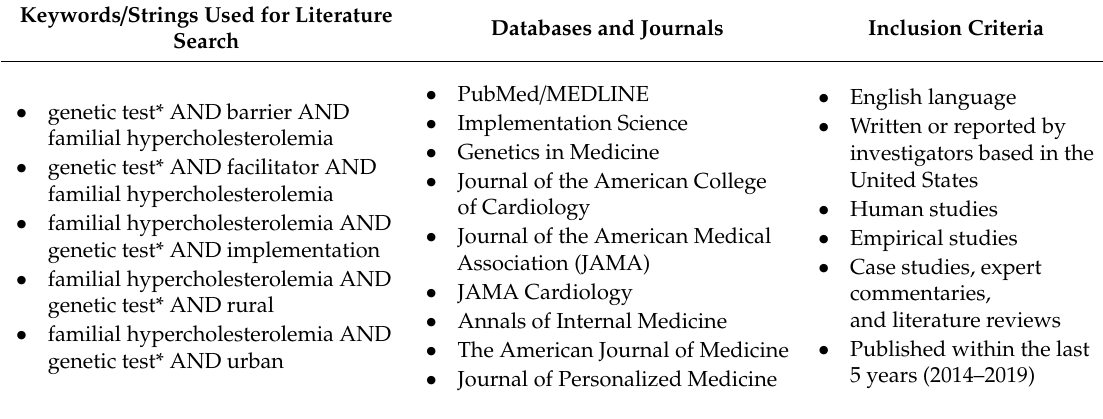
Table 1. Search Strategy: Keywords, Search Strings, Databases and Journals, and Inclusion Criteria.